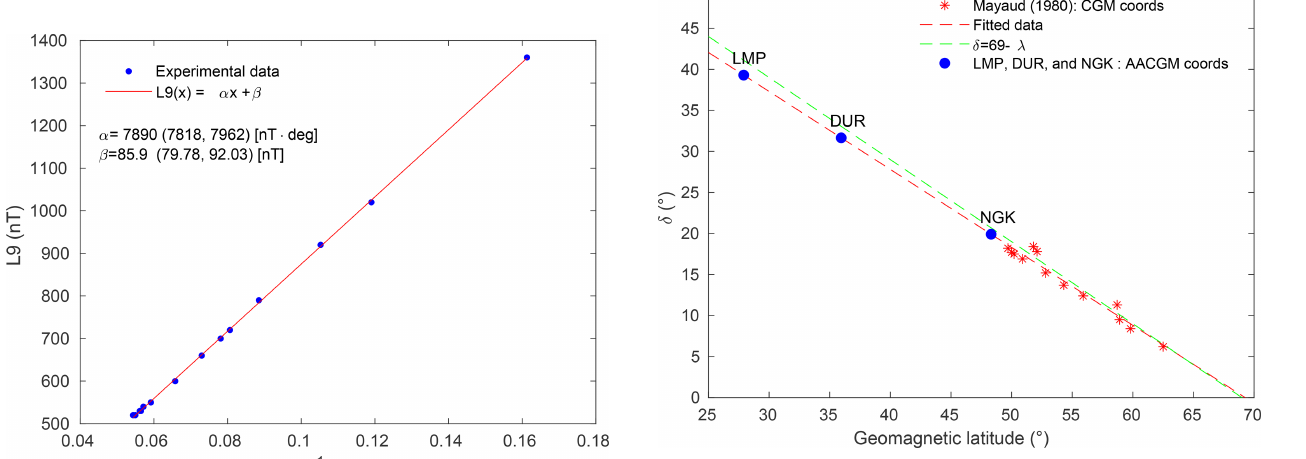
Figure 9. The linear relation between δ and the corrected geomag- netic latitude λ (Eq. 2), with values from Mayaud (1980) indicated by red stars and the extrapolated values for our observatories by pink dots. The linear regression fit is shown in red, and the relation δ = 69 ◦ − λ is shown in green. The blue dots indicate LMP, DUR, and NGK with AACGM latitudes and extrapolated δ th (see the text for